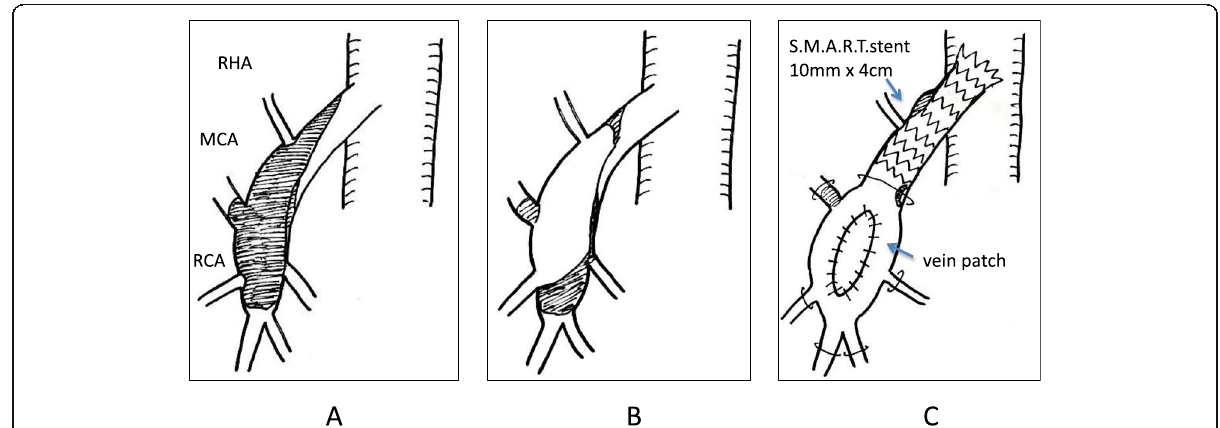
Fig. 3 Schema of proximal superior mesenteric artery portion a 4 days after the symptom onset, b 36 days after the symptom onset (before revascularization), and c after revascularization. RHA, right hepatic artery; RCA, right colic artery; MCA, middle colic